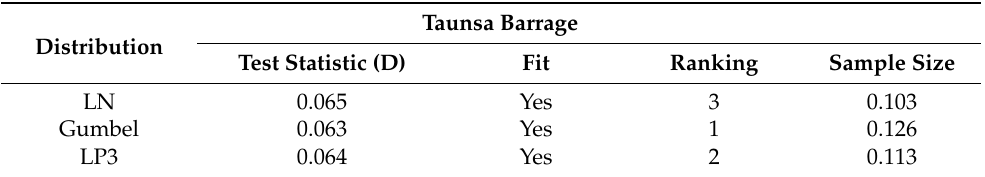
Figure 6. The discharge of the Indus River at Taunsa Barrage using the log-Pearson type III, Gumbel, and log-normal probability distributions. Table 5. Result of the K-S statistical test at Taunsa Barrage.